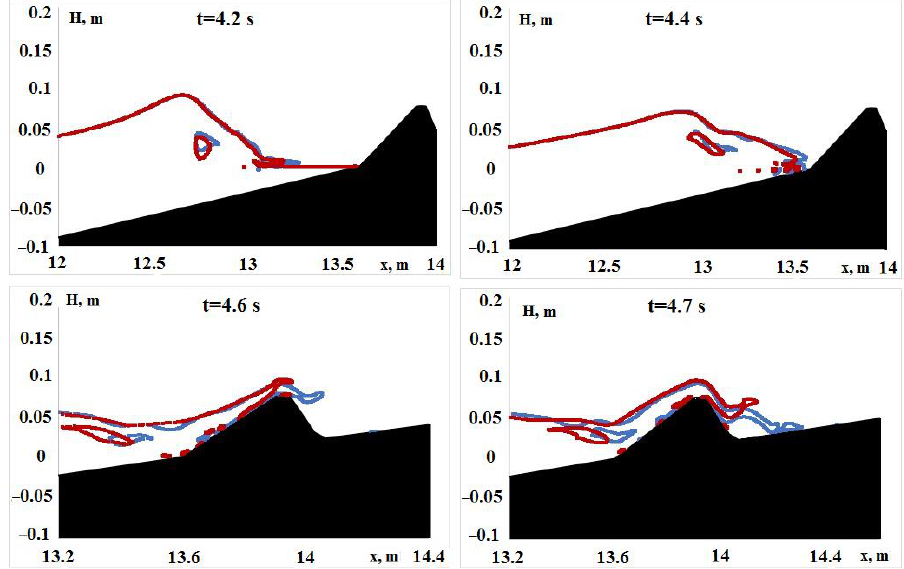
Figure 8. Comparison of the wave profiles for setup 3 ( —without TM, —with TM).